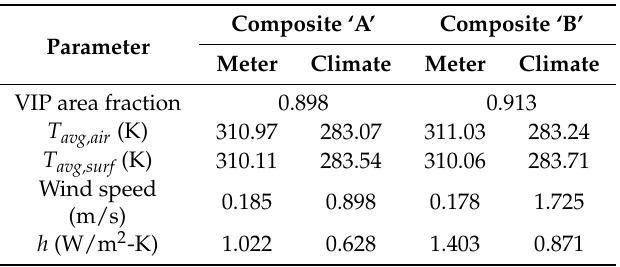
Table 5. Hot box test parameters and simulation inputs.